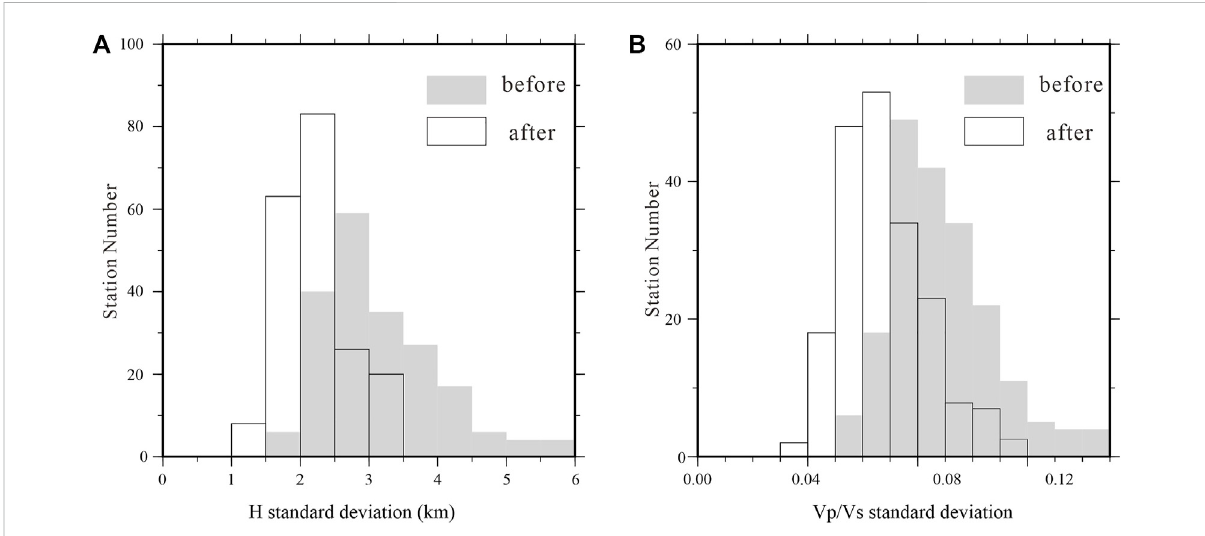
FIGURE 5 Comparison of the H- κ stacking standard deviation both before and after harmonic corrections. (A) Histogram of the differences of H (dH). (B) Histogram of the difference of Vp/Vs (d κ